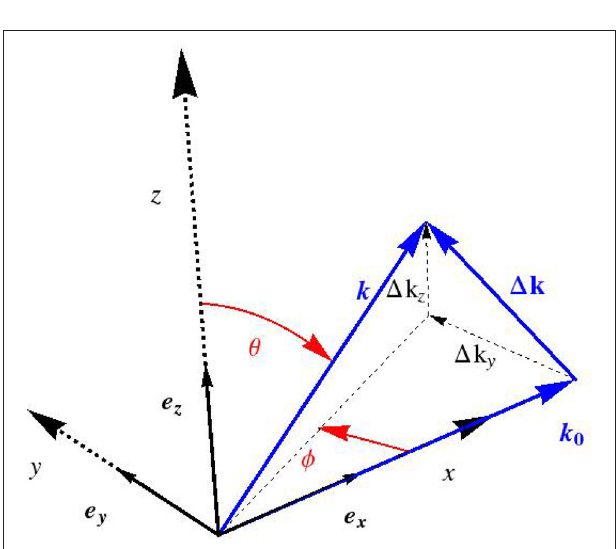
FIGURE 2 | Scattering vector 1 k in Cartesian coordinate systems ( x , y , z ) fixed to the sample.